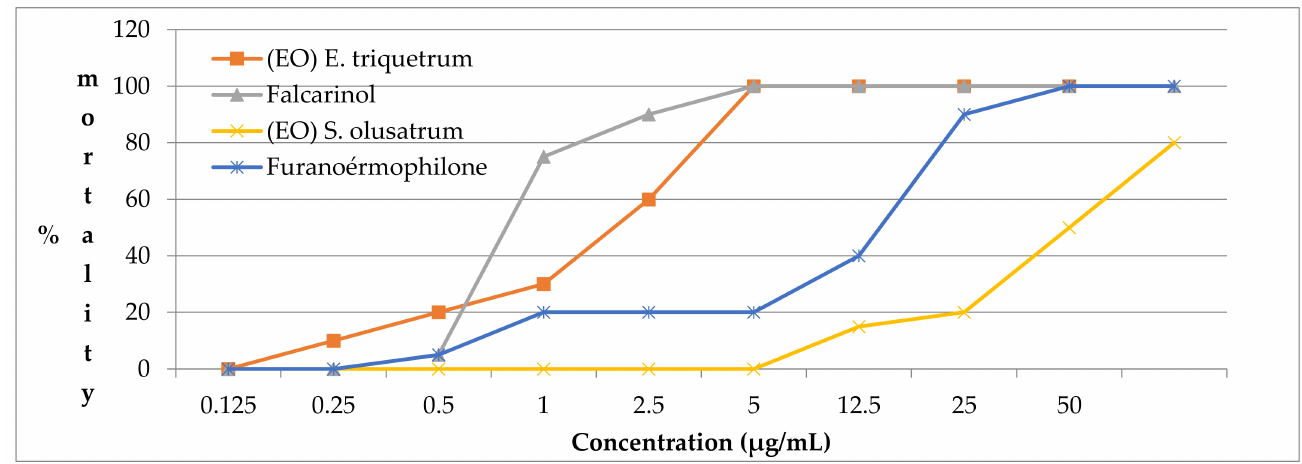
Figure 3. The death rate of Artemia at different concentrations of essential oils E. triquetrum and S. olusatrum and major